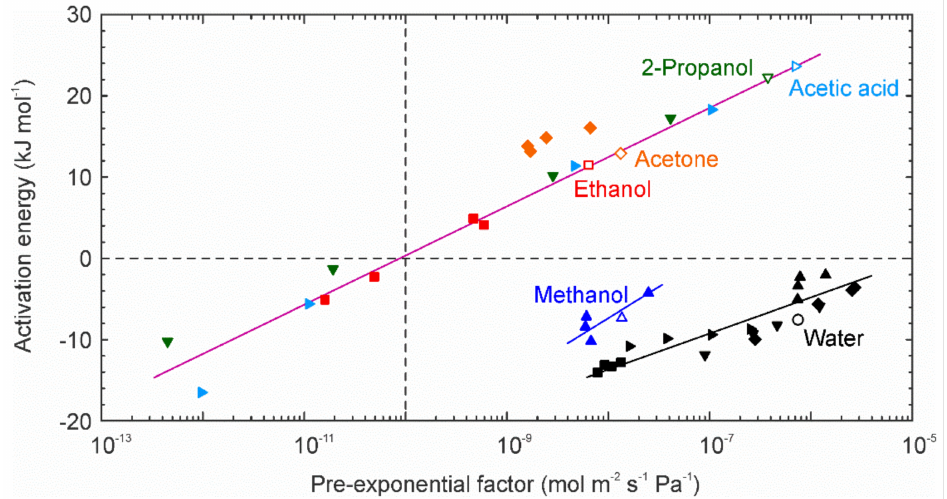
Figure 9. Relationship between pre-exponential factors and activation energies for permeation through the high-silica CHA-type zeolite membrane. (Open key) pure components and (closed key)